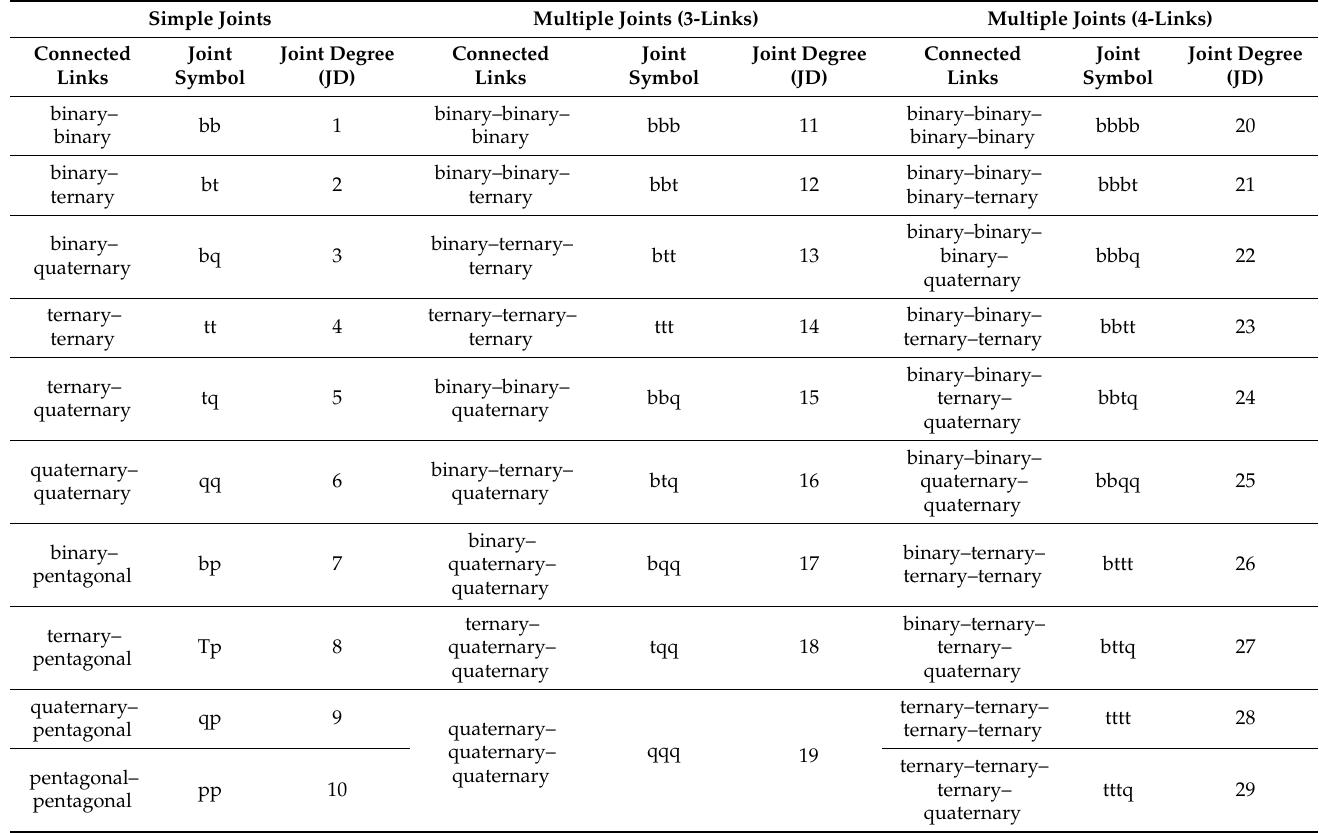
Table 1. Joint degree (JD) for simple and multiple joints according to their connectivity.